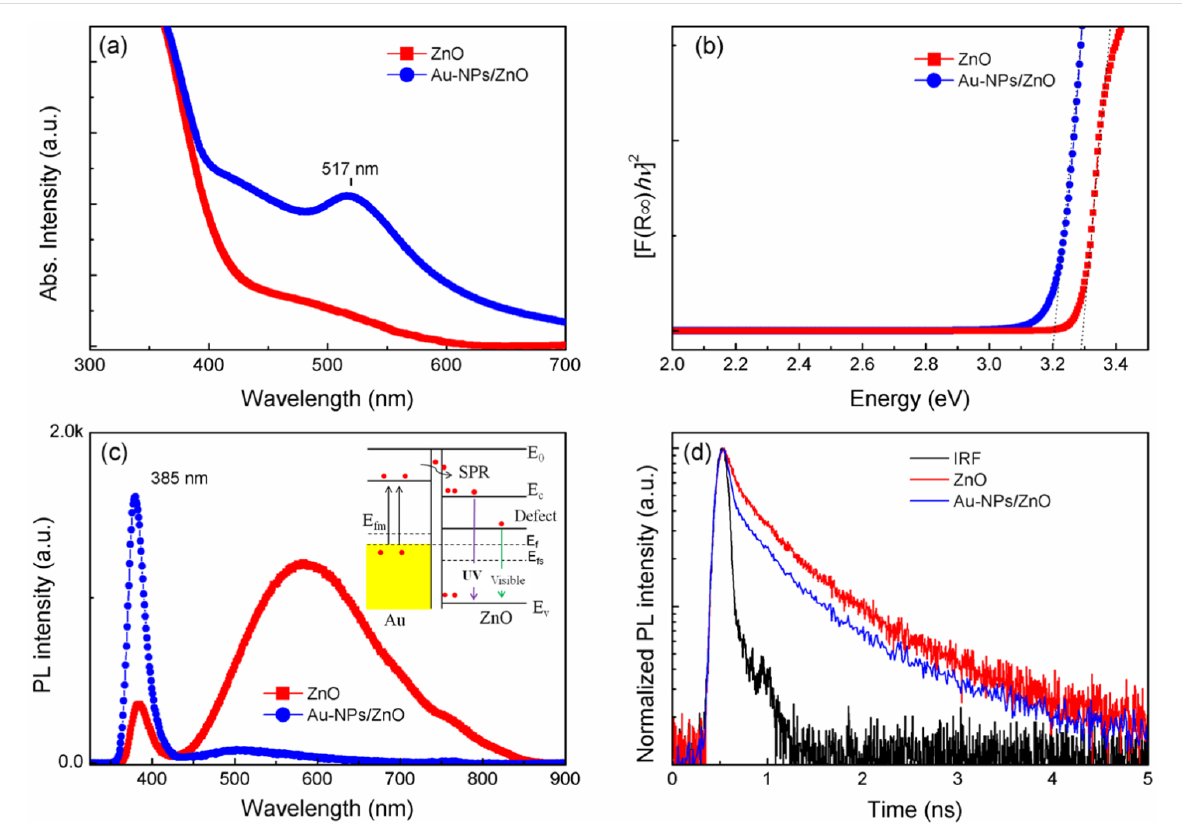
Figure 3: (a) Absorption spectra; (b) Kubelka–Munk transformed spectra; (c) photoluminescence spectra at room temperature; and (d) time-resolved photoluminescence spectra at room temperature of as-deposited ZnO and Au NP/ZnO films. The instrument response function (IRF) was less than 130